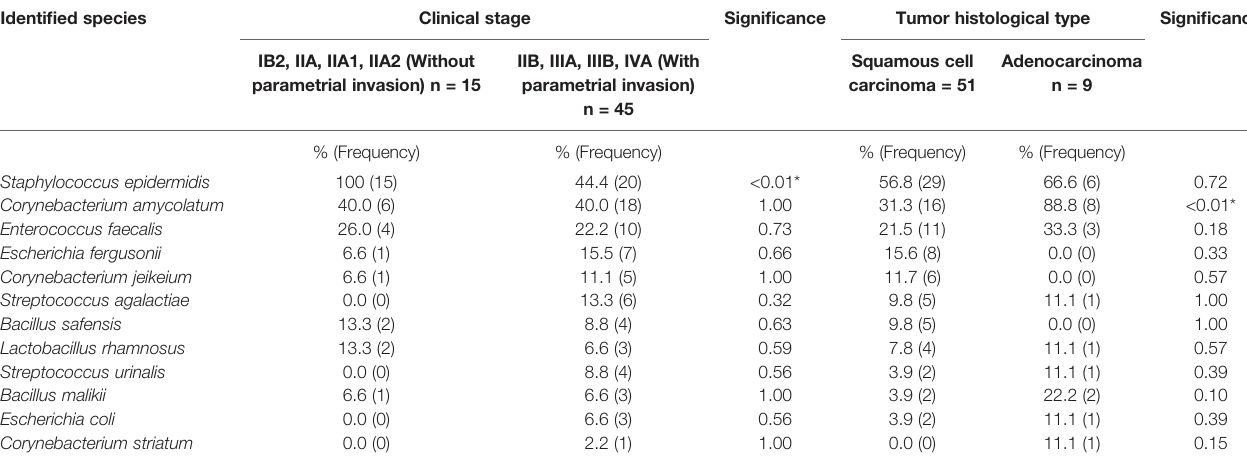
TABLE 3 | Difference in proportions of bacterial species found according to the clinical stage of the disease and histological type of